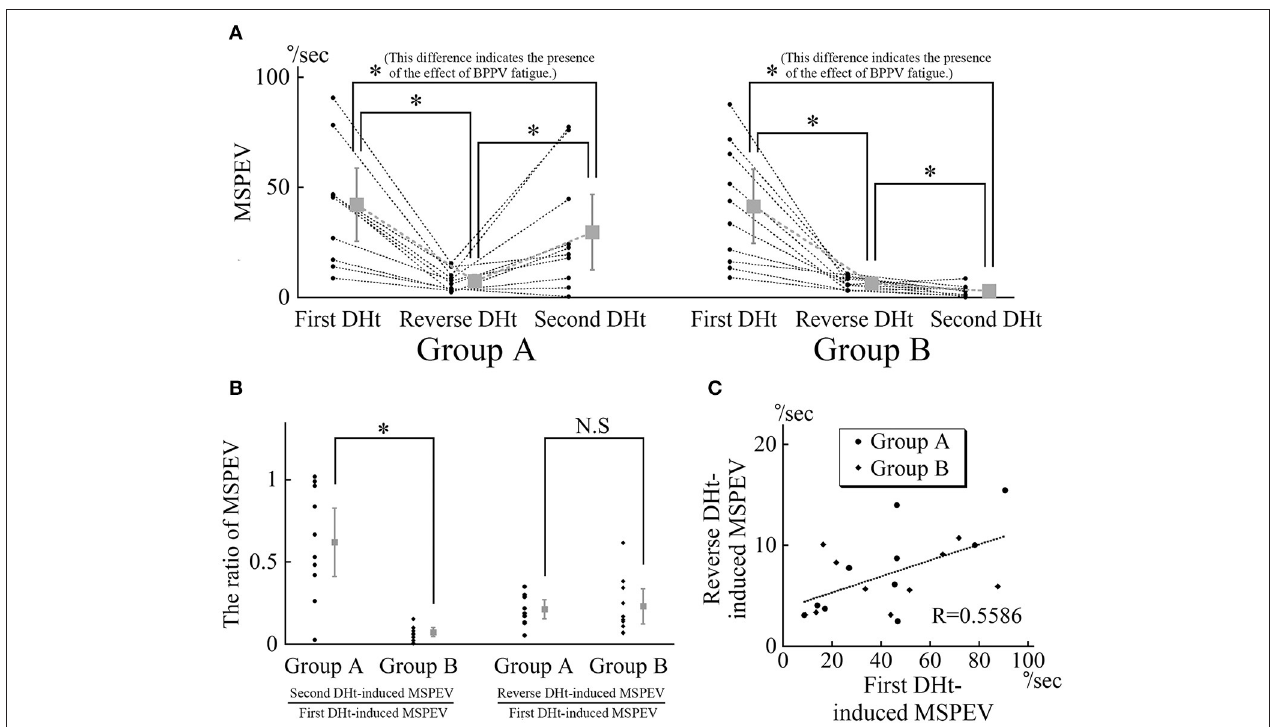
FIGURE 4 | MSPEVs of the positional nystagmus in 10 patients allocated to group A and 10 patients allocated to group B. (A) MSPEVs of the positional nystagmus induced by the first, reverse, and second Dix–Hallpike tests in groups A and B. In both groups A and B, there were significant differences in all combinations of MSPEVs. The difference in the MSPEV of the positional nystagmus between that induced by the first and second Dix–Hallpike tests indicates an effect of benign paroxysmal positional vertigo (BPPV) fatigue. (B) The ratio of the MSPEV of the positional nystagmus against the MSPEV of the positional nystagmus induced by the first Dix–Hallpike test. Left graph: the ratio of the MSPEV of the positional nystagmus induced by the second Dix–Hallpike test against that induced by first Dix–Hallpike test. The ratio in group B was significantly smaller than that in group A. Right graph: the ratio of the MSPEV of the positional nystagmus induced by the reverse Dix–Hallpike test against that induced by the first Dix–Hallpike test. There were no differences in the ratio between in groups A and B. (C) The relationship between the magnitude of the MSPEV of the positional nystagmus induced by the first Dix–Hallpike test and that induced by the reverse Dix–Hallpike test. The